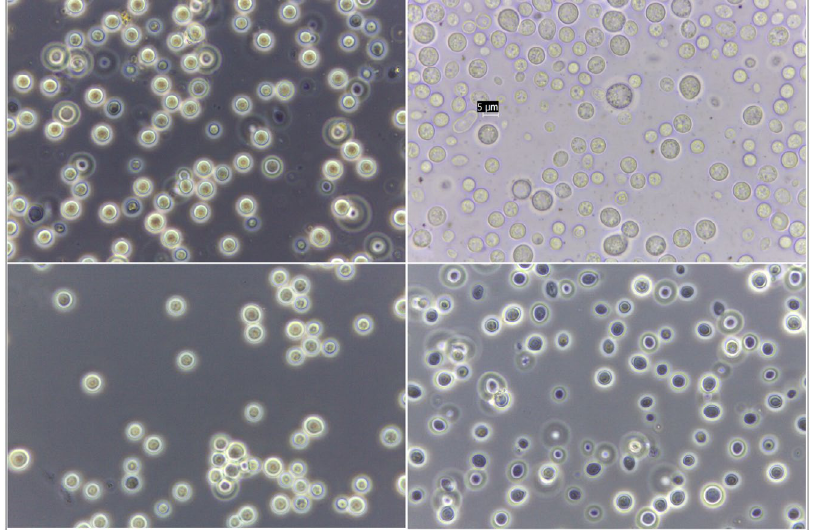
Fig. 8. Phase contrast microscopy of Nagashia albida under 100x